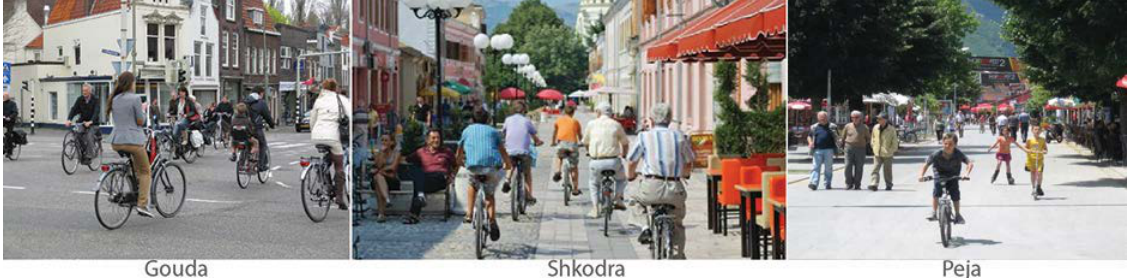
Figure 3. Cycling in the pedestrianized centers of three case study cities In total, 16 interviews were conducted in Gouda, 15 in Peja, and 15 in Shkodra. The interviews took place between summer 2013 and winter 2014 and lasted between 30 and 60 minutes each. Some interviews were conducted in person and some by telephone or Skype. Overall, the study participants in all three cities tended to be more educated than the population at large. In Shkodra and Peja the participation of younger people was broader while in Gouda older people and parents of small or teenage children tended to volunteer more often. The gender mix was balanced but participants tended to be car owners (although car ownership in not universal in any of the three cities). In Gouda, many participants worked in another city, reflecting a longer average commutes than in the other two cities. (Commuting to another city for work is common in the Netherlands, as the national communication network is of high